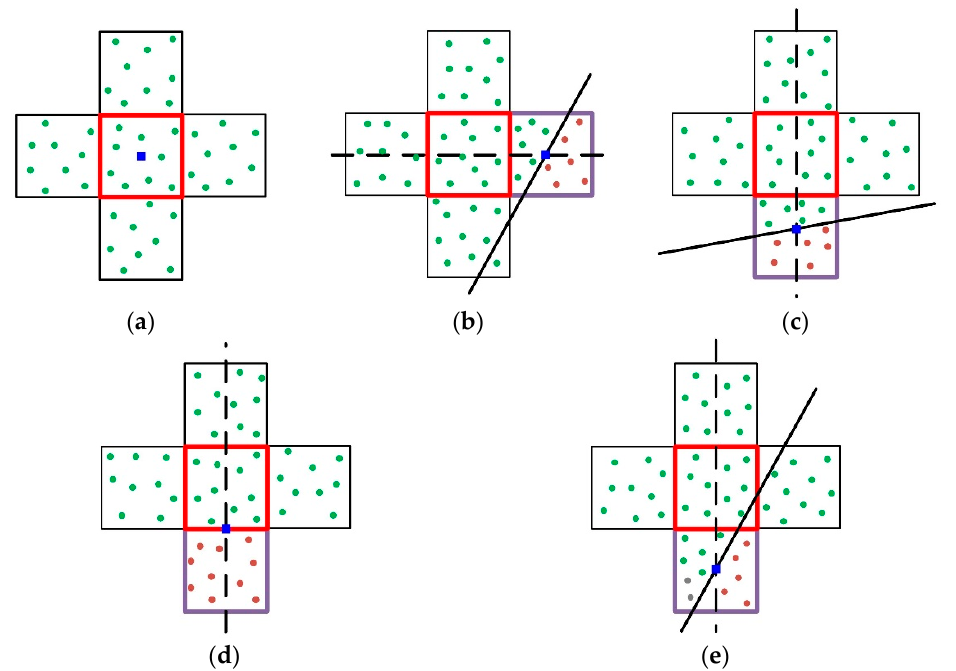
Figure 4. Calculation of layer-connection points, points with different colors representing different roof layers, and the blue rectangle representing the x – y coordinates of the derived layer-connection point: ( a ) the points inside the five cells belonging to the same roof layer; and ( b ), ( c ), ( d ), ( e ) the points inside the five cells belonging to different roof layers.